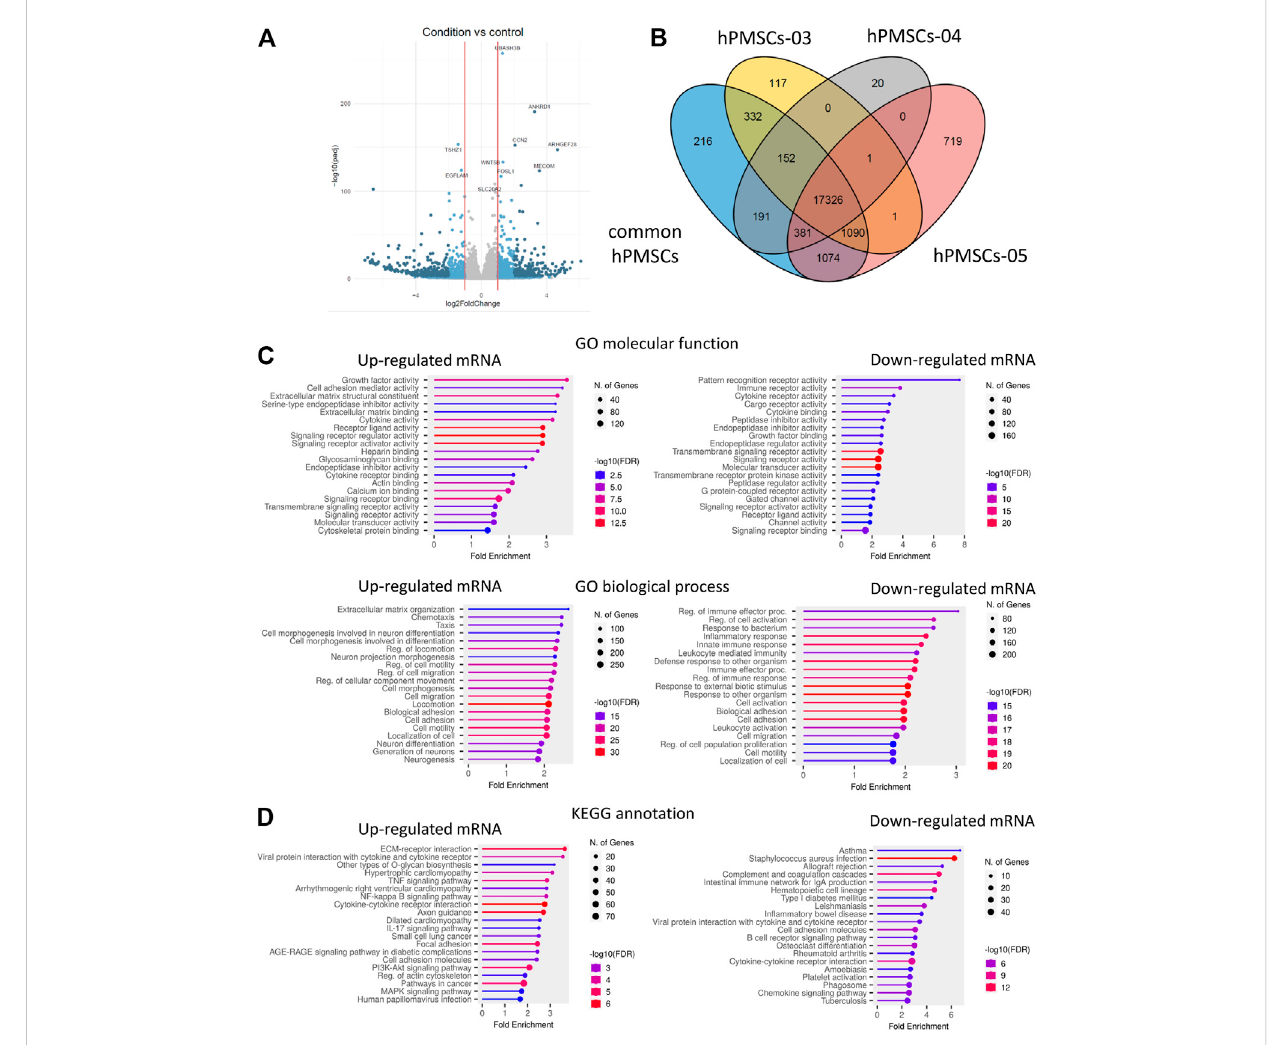
Transcriptome analysis of native and cryo hPMSCs. (A) Volcano plot for the genes differentially expressed between native and cryo hPMSCs. Darker colors correspond to lower p-adj values. (B) Venn diagram of independent comparison of numbers of differentially expressed genes; hPMSCs-03 – 05 represent three independent comparisons of native vs. cryo hPMSCs. (C) Gene Ontology overrepresentation analysis of the 3,514 genes falling into the cryopreservation-sensitivegroup. (D) KEGGannotationofdifferentiallyexpressed genesincryohPMSCs.Experimentswereperformedinbiological triplicates. The genes with p-adj < 0.05 were considered signi fi cant, log2Fold < − 0.5 — downregulated, log2Fold > 0.5 — upregulated. FDR, false discovery